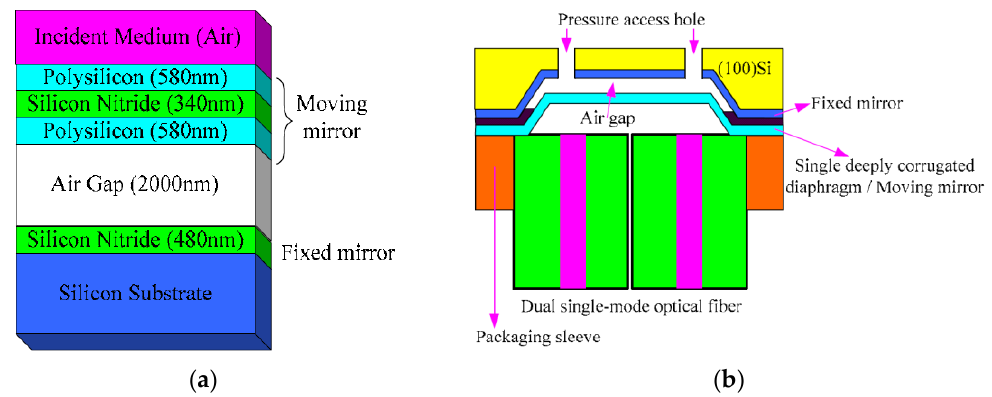
Figure 11. ( a ) Structural parameters of the F-P microcavity; ( b ) Schematic view of dual optical fiber F-P pressure sensor. (Reproduced from [22]).